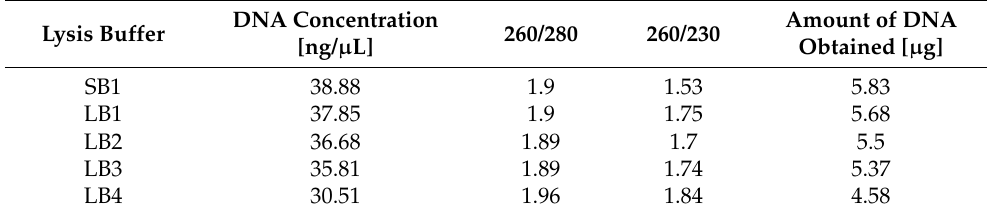
Table 2. DNA concentration and purity determined by spectrophotometric analysis, obtained using here developed lysis